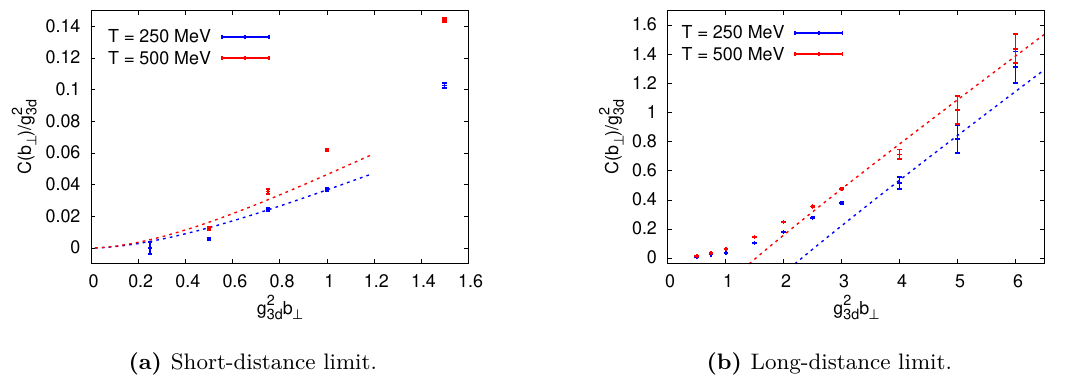
Figure 1. Short-distance (a) and long-distance (b) behavior of the momentum broadening kernel C QCD ( b ⊥ ) . Dashed lines correspond the asymptotic functional forms in (2.6) and